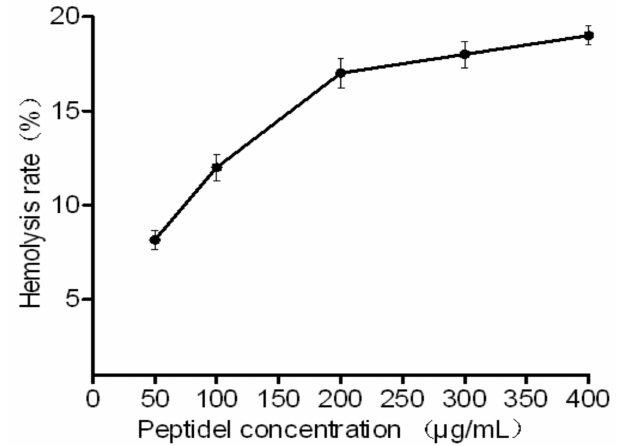
Figure 3. Toxicity of HJH-1 in vitro. Hemolytic activities of HJH-1 at various concentrations upon incubation with red blood cells for one hour. All data are presented as the mean ± SD ( n =